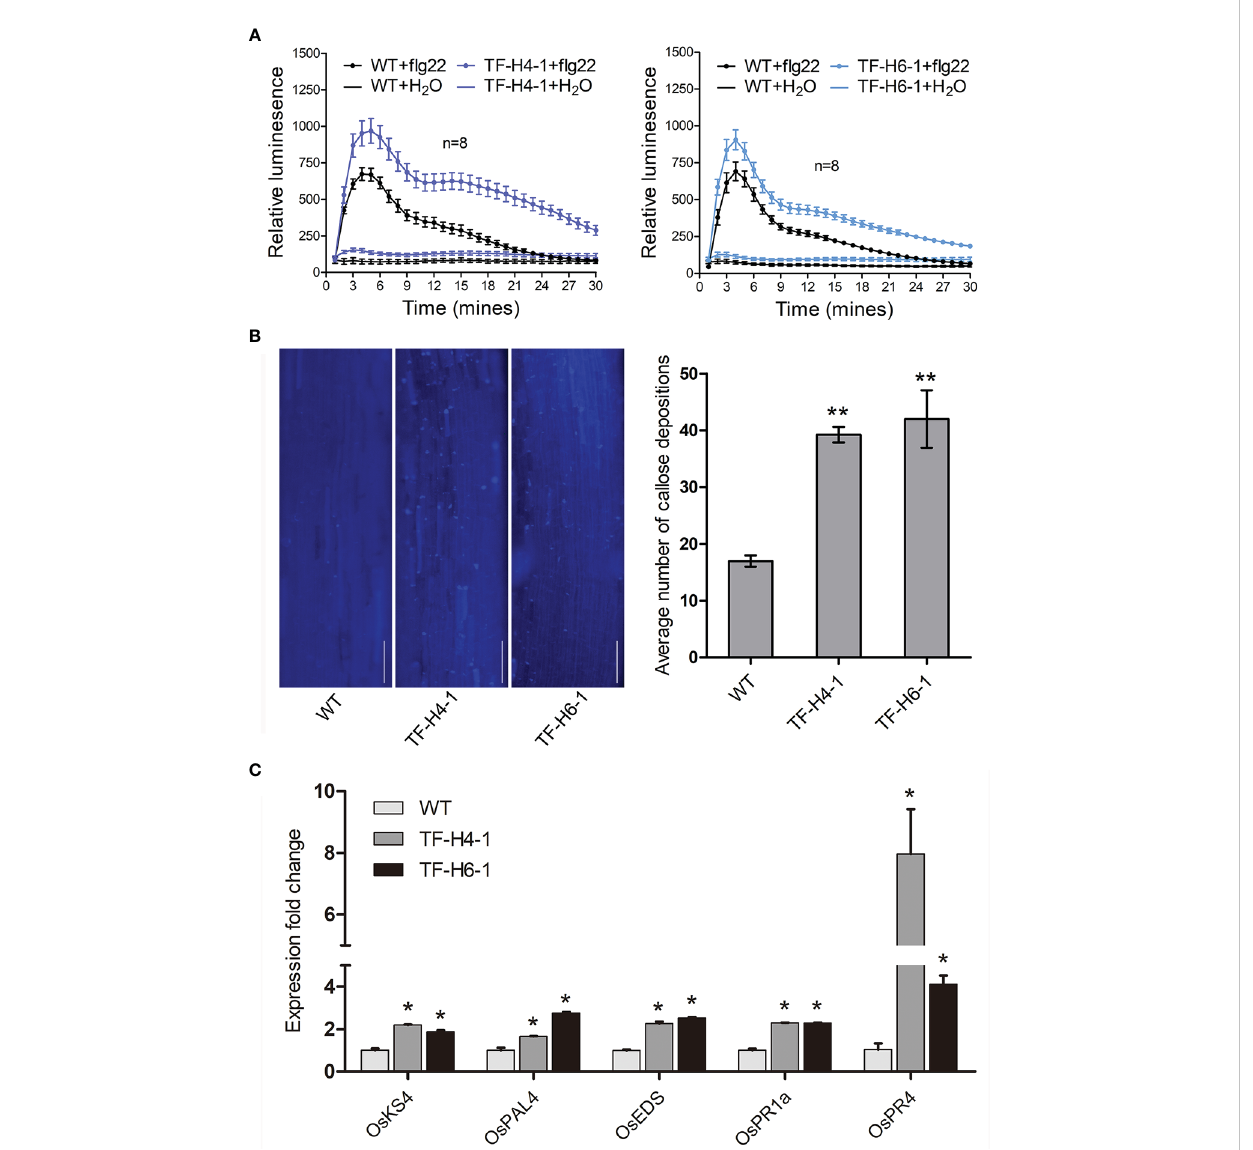
FIGURE 4 Plant immune responses in the loss-of-function mutants of OsHPP04 after fl g22 treatment. (A) ROS burst from the different shoot discs treated with 1 m M fl g22 was measured by Photek camera system between 0 and 30 min. Bars represent mean ± SE (n = 8 biological replicates). (B) Callose deposition in rice roots after treatment with 1 m M fl g22 for 12 h. The average amount of callose depositions were measured by ImageJ. Data were analyzed by a two-tailed Student ’ s t-test (** P < 0.01. Values are mean ± SE ). Bars = 50 m m. (C) Expression levels of defence-related genes ( OsKS4 , OsPAL4 , OsEDS1 , OsPR1a and OsPR4 ) were determined by quantitative real-time polymerase chain reaction in rice after treatment with 1 m M fl g22 for 1 h. Values are mean ± SE , * P <0.05, Student ’ s t -test. The rice Ubiquitin gene ( OsUBQ ) was used as an internal control. WT: wild-type rice; TF- H4-1 and TF-H6-1: two ‘ transgene-free ’ OsHPP04 mutant lines. Three independent experiments were performed with similar